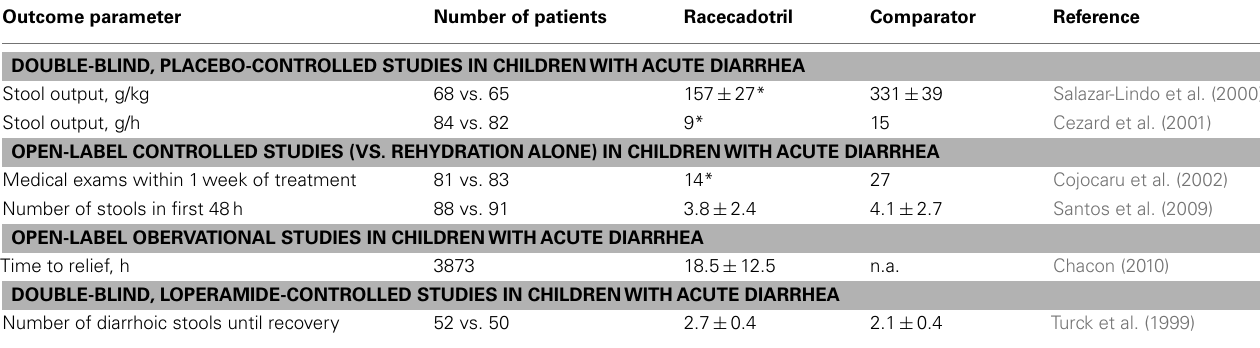
Table 2 | Efficacy of racecadotril in the treatment of acute diarrhea in children. Outcome